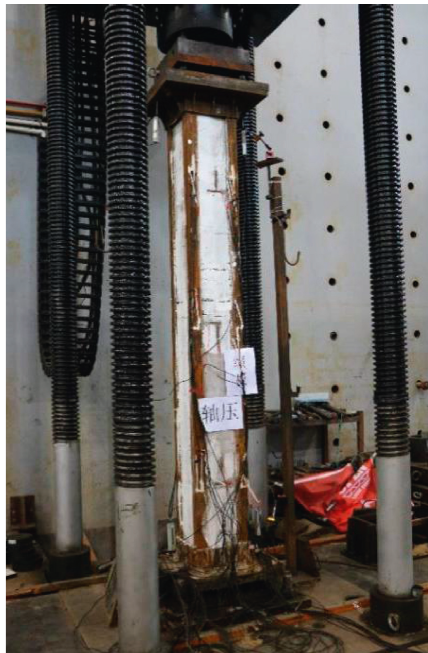
Figure 5: Test loading device.